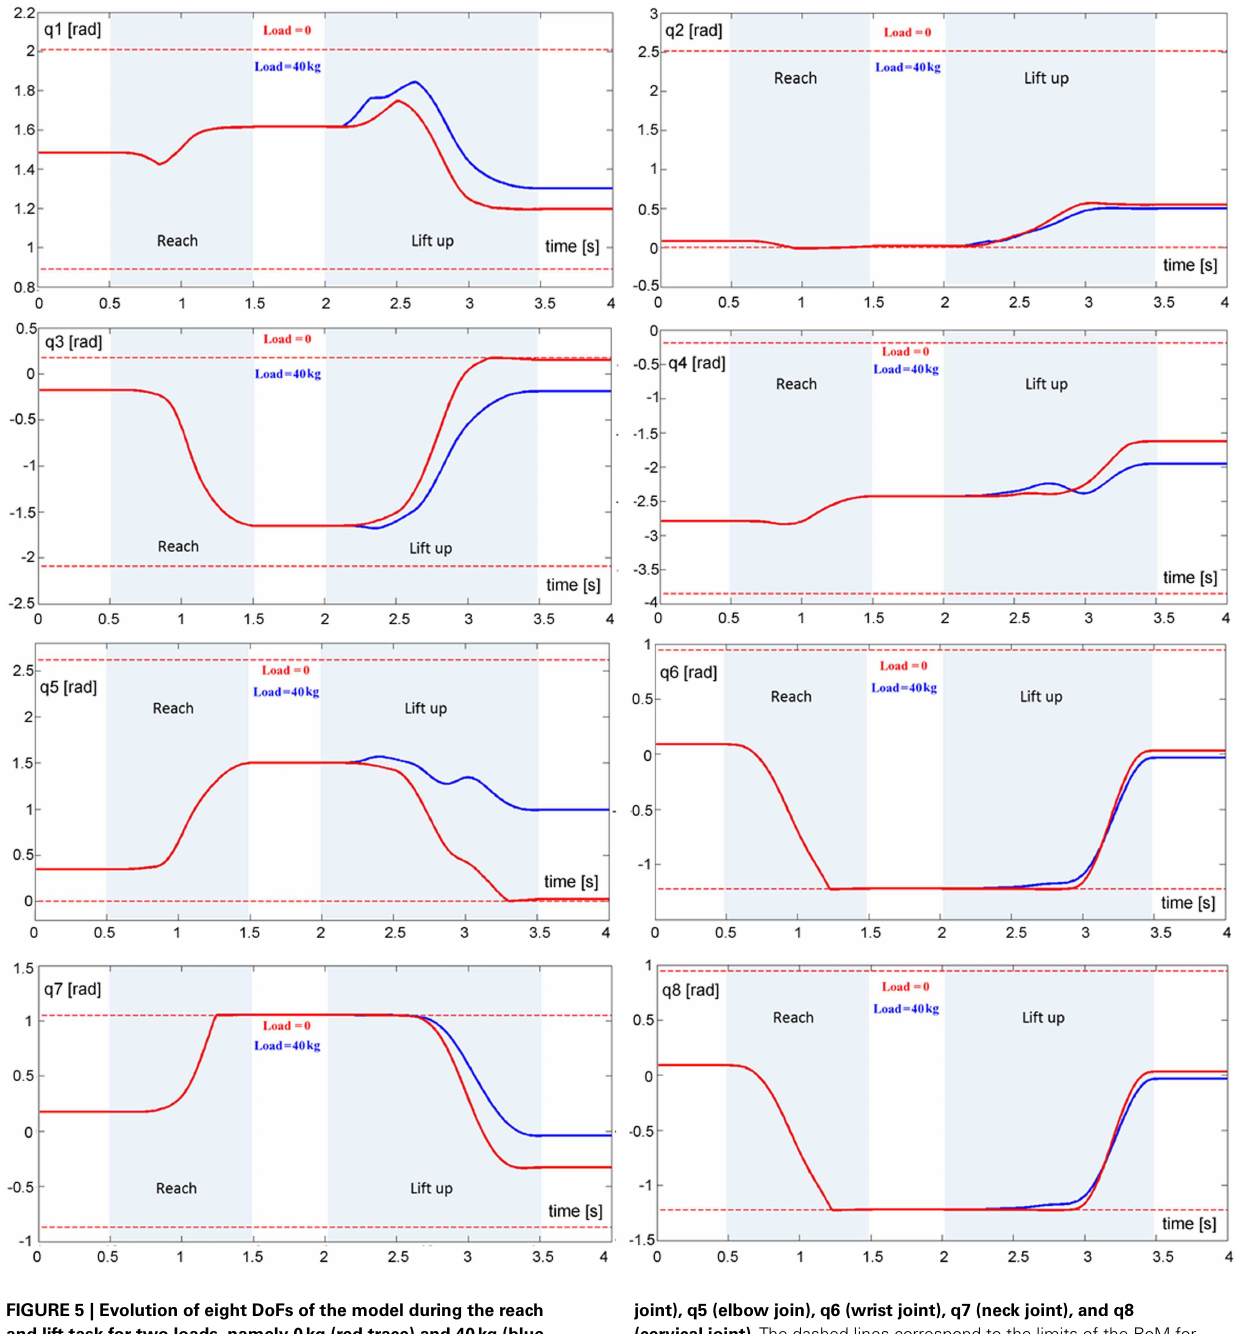
joint), q5 (elbow join), q6 (wrist joint), q7 (neck joint), and q8 (cervical joint) .The dashed lines correspond to the limits of the RoM for each